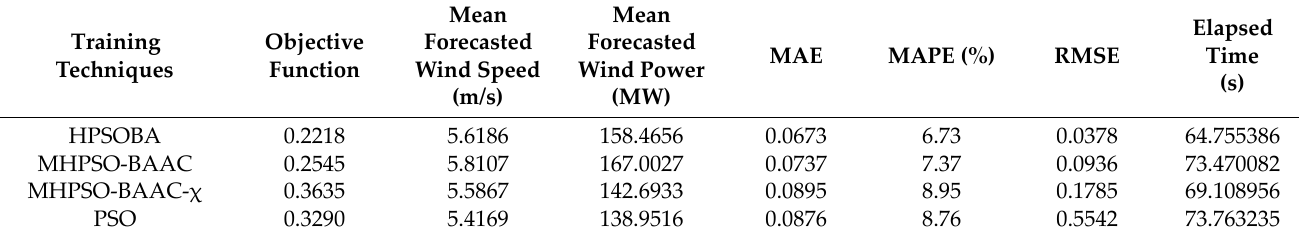
Table 2. Values of the mean forecasted wind speed, power, and accuracy testing parameter through FFNN.